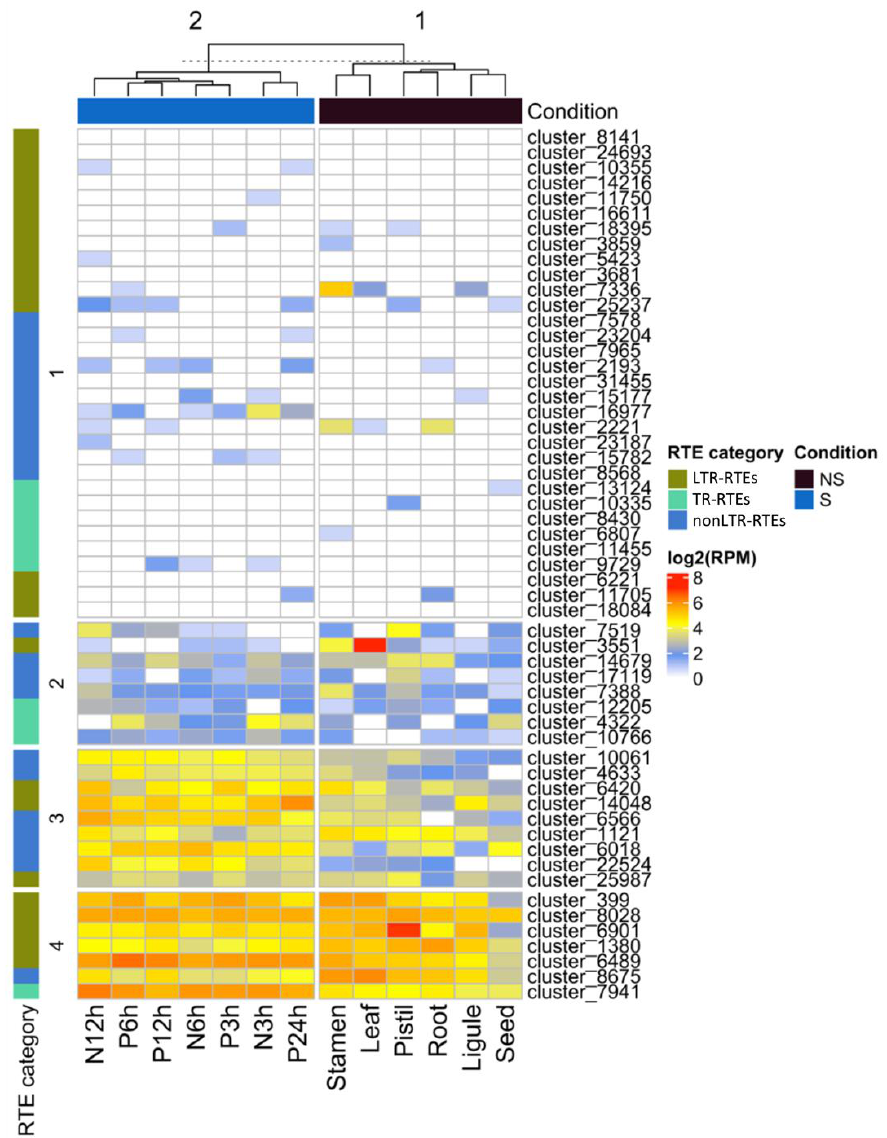
Figure 4. Heatmap of the expression (log2(RPM)) of different categories of RTE transcripts in stress (S) and non-stress (NS) conditions based on RNAseq data. RTE transcripts are clustered based on Pearson distance hierarchical clustering. Clusters 1 – 4 are labeled on the left side of the heatmap. The materials for the RNAseq used for this analysis were the seed, ligule, root, pistil, leaf, stamen, and plants treated by NaCl (3 (N3h), 6 (N6h), and 12 (N12h) h) and Polyethylene Glycol (3 (P3h), 6 (P6h), 12 (P12h), and 24 (P24h) h).